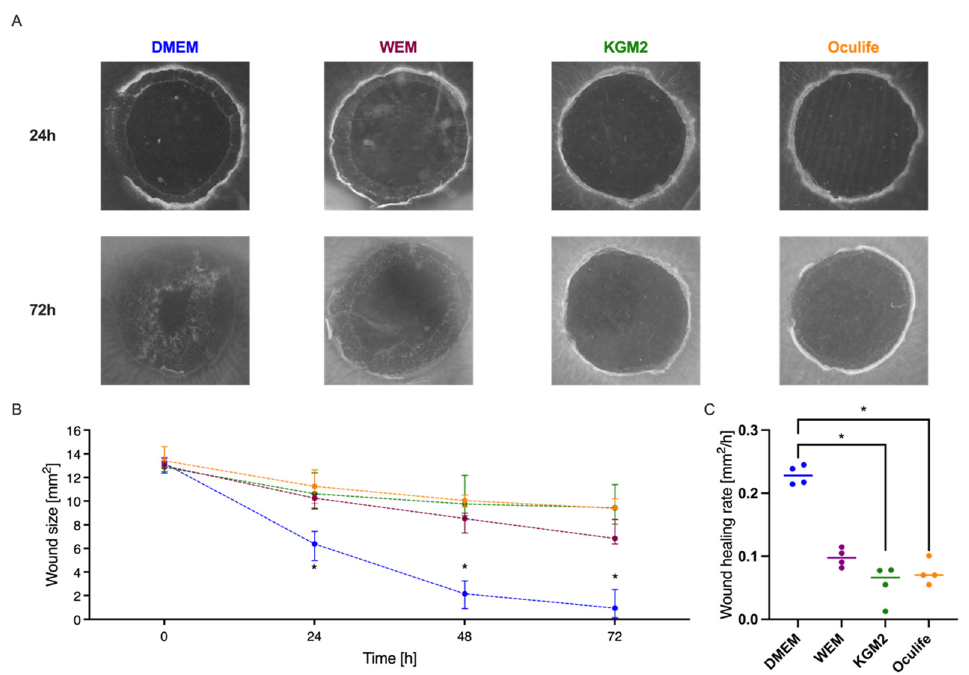
Figure 6. Comparison of wound healing rates in different cell culture media. The wound healing of ex vivo cultured corneas was determined evaluating the effect of different culture media. The corneal lesion was generated with a 4 mm biopsy punch. After 24 h, 48 h and 72 h of culture the wound size was calculated. ( A ) Images, which illustrate the wound healing performance were shown for 24 h and 72 h. ( B ) The tested media were Dulbecco’s modified eagle medium (DMEM, blue line), Williams E Medium (WEM, purple line), Keratinocyte Growth Medium 2 (KGM2, green line) and OcuLife (yellow line). ( C ) The wound healing rates were also calculated for the period from 0 h to 48 h. Sample size n = 4. Statistically significant differences are indicated as *: p <